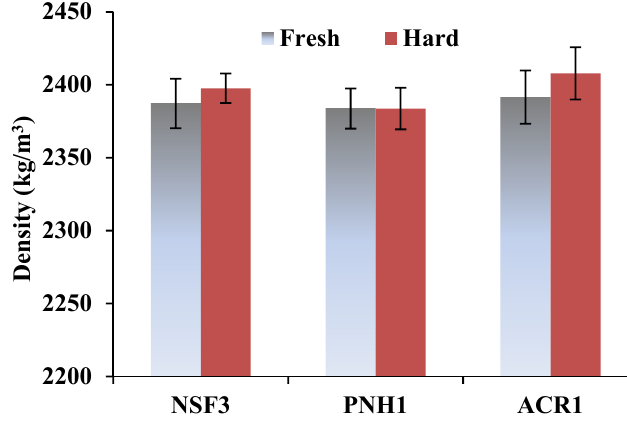
Figure 6. Density of fresh and hard concrete (mean value for all cements).